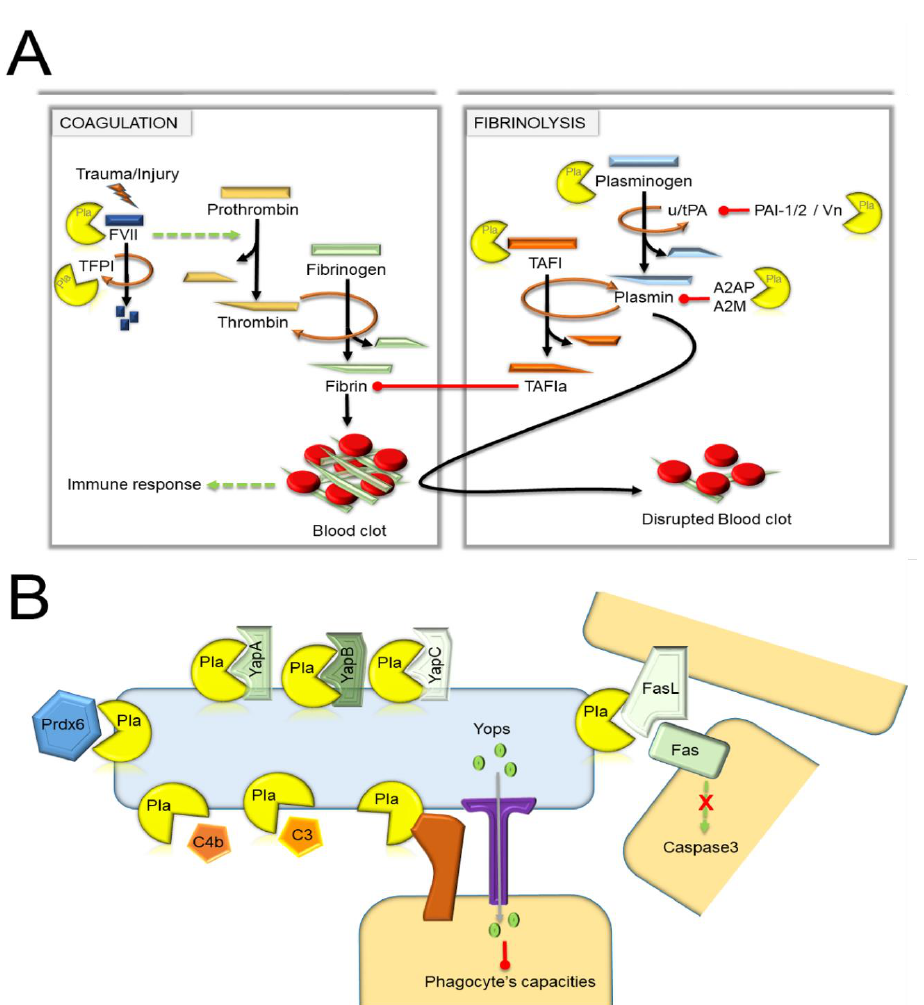
Figure 3. The di ff erent substrates of Pla. ( A ) Hemostasis cascade. Trauma or an injury activates the coagulation cascade, which leads to the production of a blood clot. The fibrinolysis inhibits the coagulation cascade and disrupts the blood clot. Dashed green and brown circular arrowheads indicate respectively a multiple steps process and a single step leading to protein cleavage. Black arrowheads show the di ff erent products of the cleaved protein. Red lines with ball indicate inhibition. Pla (pacman) acts as a protease. ( B ) The Pla protease cleaves proteins located at the surface of the bacteria (blue cell) and the host’s cell (yellow) or other host’s proteins. Pla also acts as an adhesin (independently of its proteolytic activity), which triggers the secretion of Yops into the host’s cell cytoplasm and inhibits the phagocyte’s ability to kill the bacteria and induce an immune response. Redline with ball indicates inhibition; dashed green arrowhead, a multiple-step process leading to caspase 3 activation; red-cross,